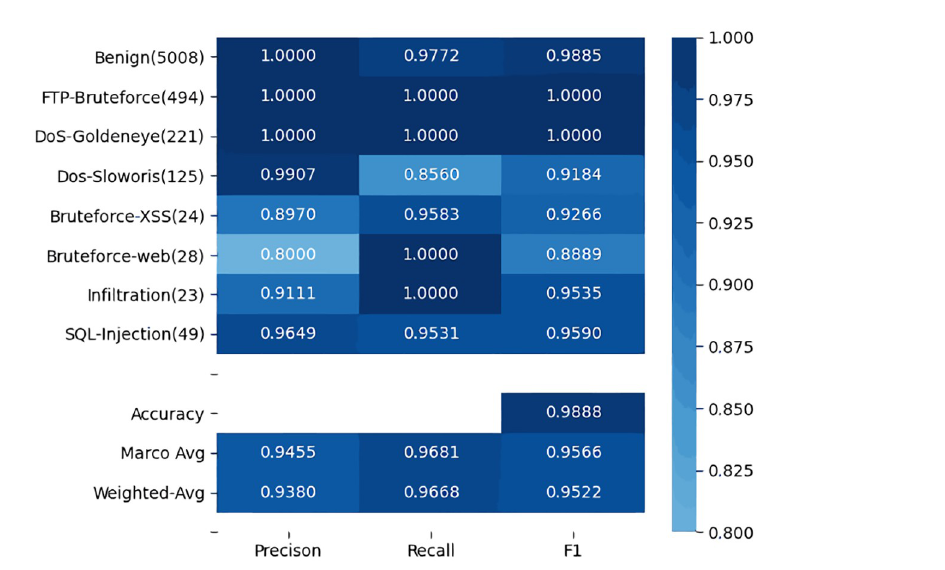
Fig 10. Heat map: The classification result of the proposed